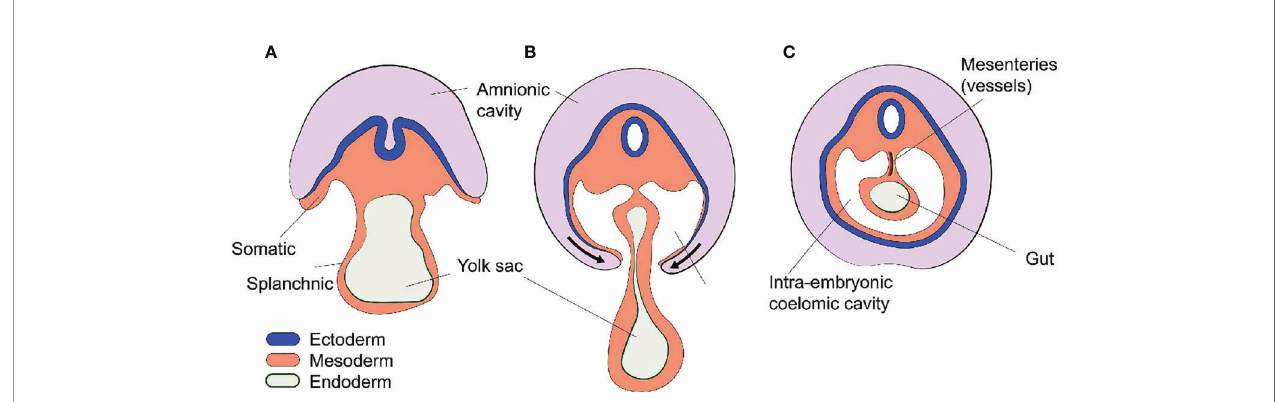
FIGURE 1 | Development of the intra-embryonic coelomic cavity. (A) Schematic cross section human embryo of 3 weeks age. The mesoderm shows a somatic (dorsal) and splanchnic (ventral) aspect. (B) Cranio-caudal and latero-lateral folding in week 4. (C) After closure of the anterior abdominal wall the intra-embryonic coelomic cavity is formed. Organs (e.g. gut) are suspended by dorsal and sometimes ventral (not shown) mesenteries carrying blood vessels and nerves.